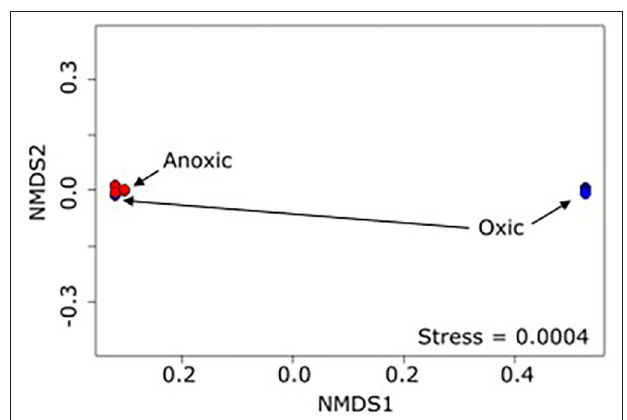
FIGURE 3 | NMDS plot (Bray-Curtis dissimilarity) of flume samples show clustering of the samples into 2 distinct groups, mostly divided by presence of dissolved